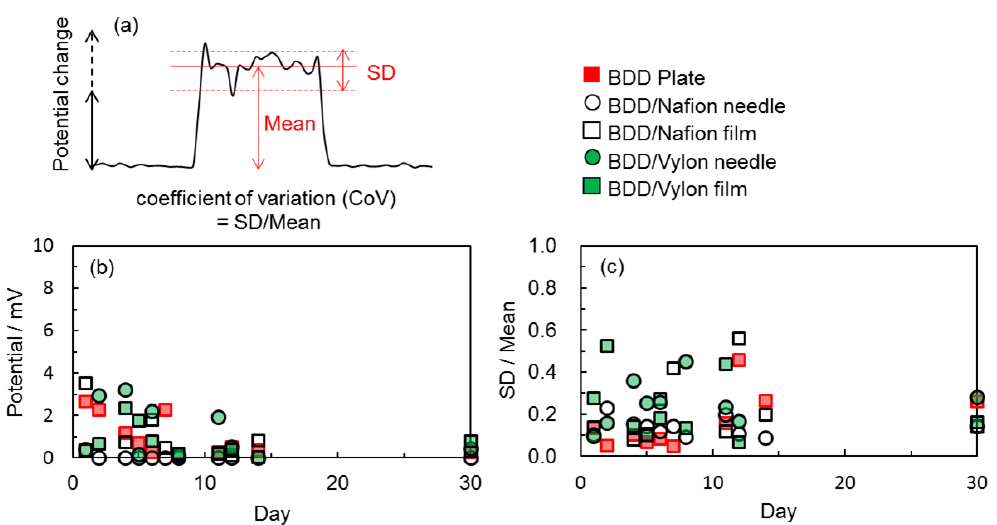
Figure 5. ( a ) Statistical analysis of the bioelectric potential changes upon a finger touch. ( b ) Mean (absolute value) of potential changes evoked by a finger touch on potted Aloe and ( c ) SD/mean (coefficient of variability) for the potential changes measured with each electrode.